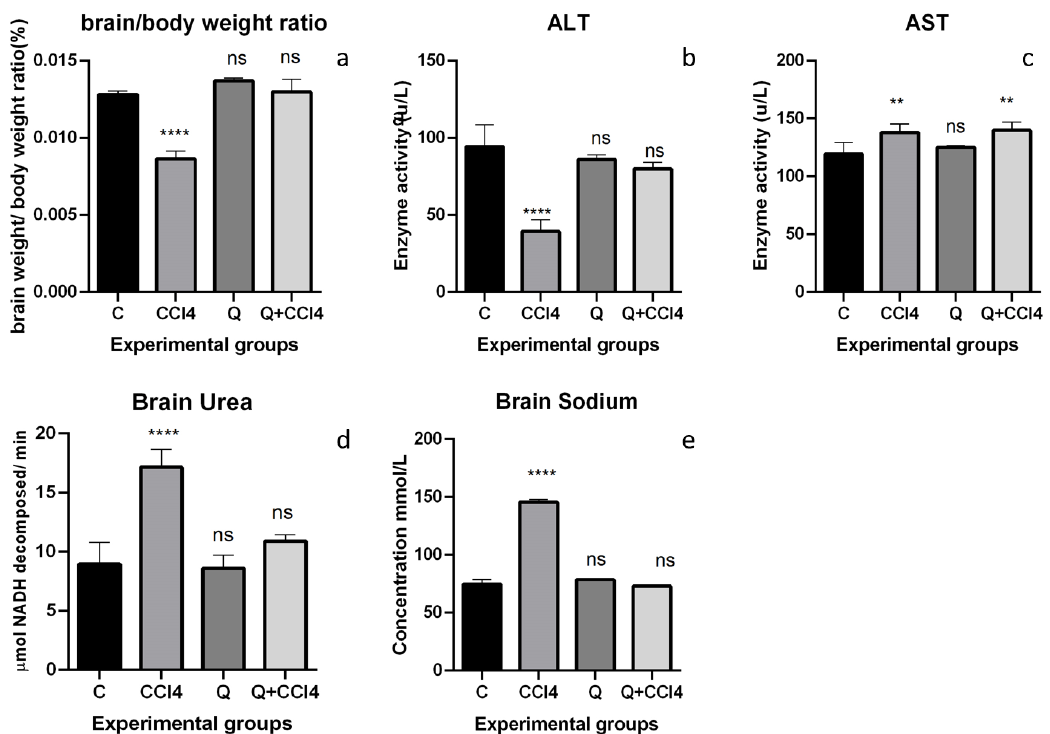
Figure 2. ( a – e ). Effect of CCL4 (1 mg/kg) and Q (100 mg/kg b.w) on the brain-to-body weight ratio, ALT, AST, brain urea, and brain sodium ( n = 6). Data were analyzed by (one-way ANOVA), and Tukey’s test was used for multiple comparisons. Treated groups are compared to the control group. **** p < 0.0001, *** p < 0.001, ** p < 0.01, * p < 0.1, ns is non-significant.